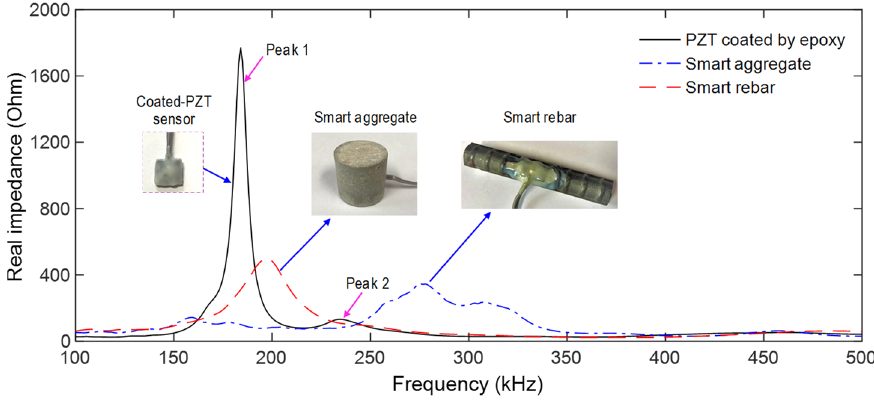
Figure 8. Impedance signatures of coated PZT sensor, smart rebar, and smart-aggregate.